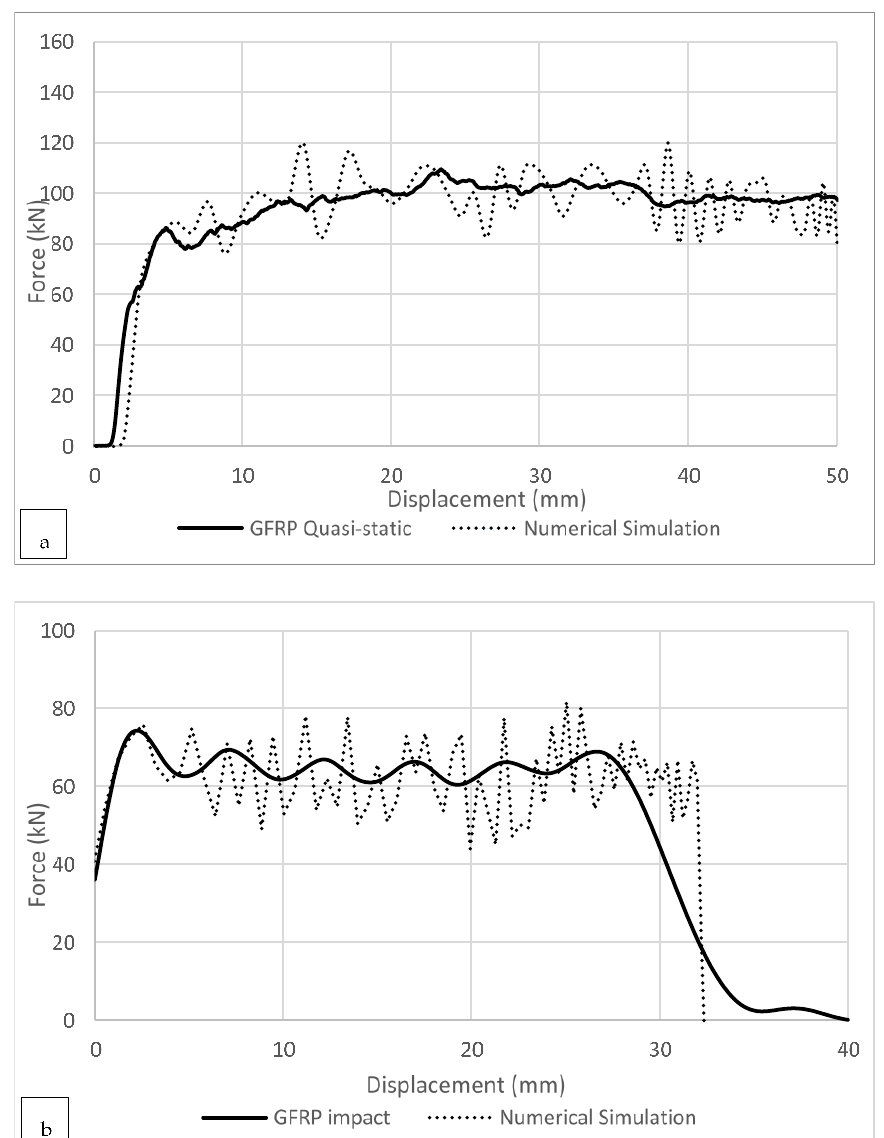
Figure 28. Force–displacement characteristic experimental and numerical comparison Figure 28. Force – displacement characteristic experimental and numerical comparison [66].